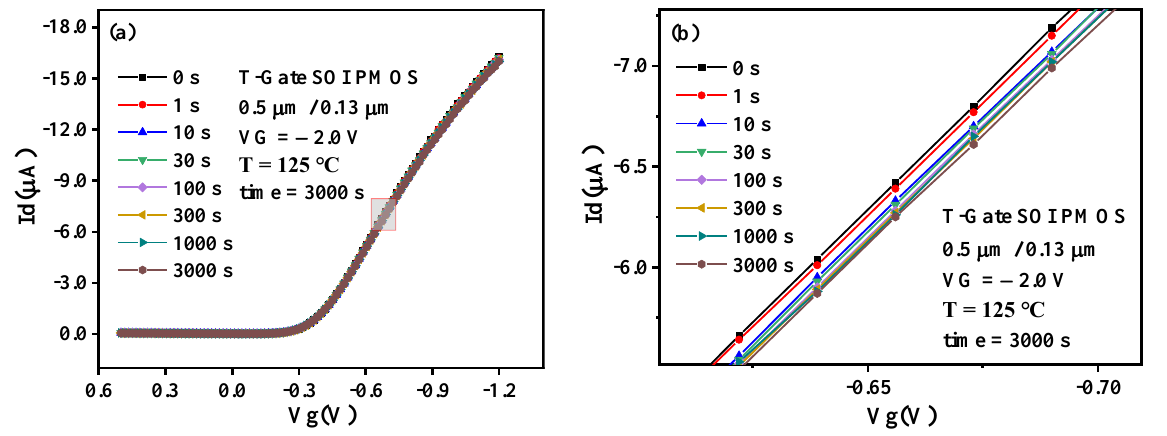
Figure 3. Transfer characteristics of PMOS before and after NBT stress. ( a ) Complete, ( b ) Enlarged.